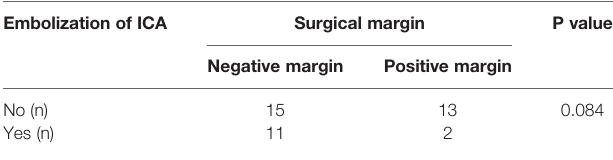
TABLE 2 | The relationship between surgical margin and ICA embolization in rNPC patients with tumor invasion of